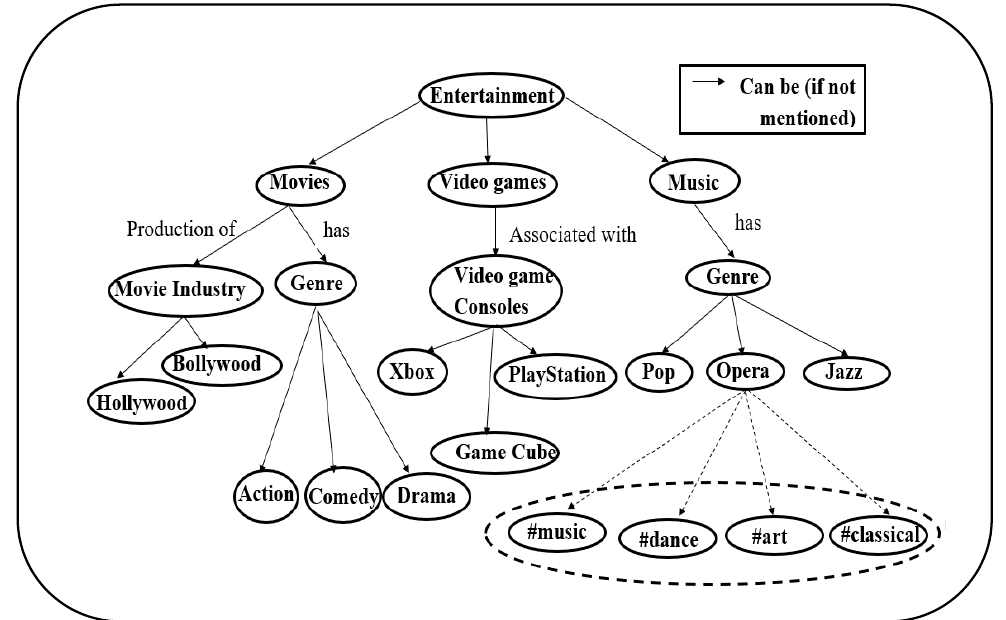
Figure 1 with the dashed lines. The same process is repeated for the ontology of the class sports. A